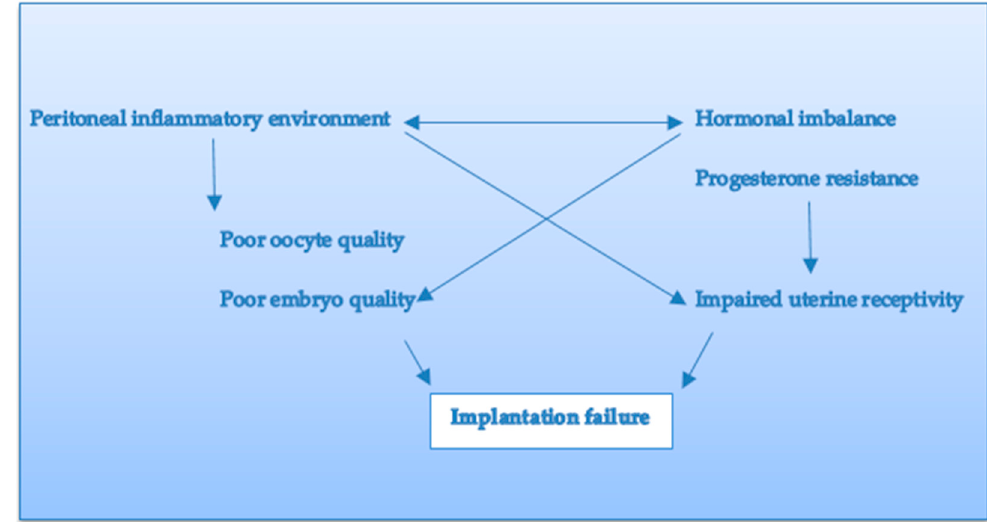
Figure 1. Possible mechanisms underlying embryo implantation in endometriosis.